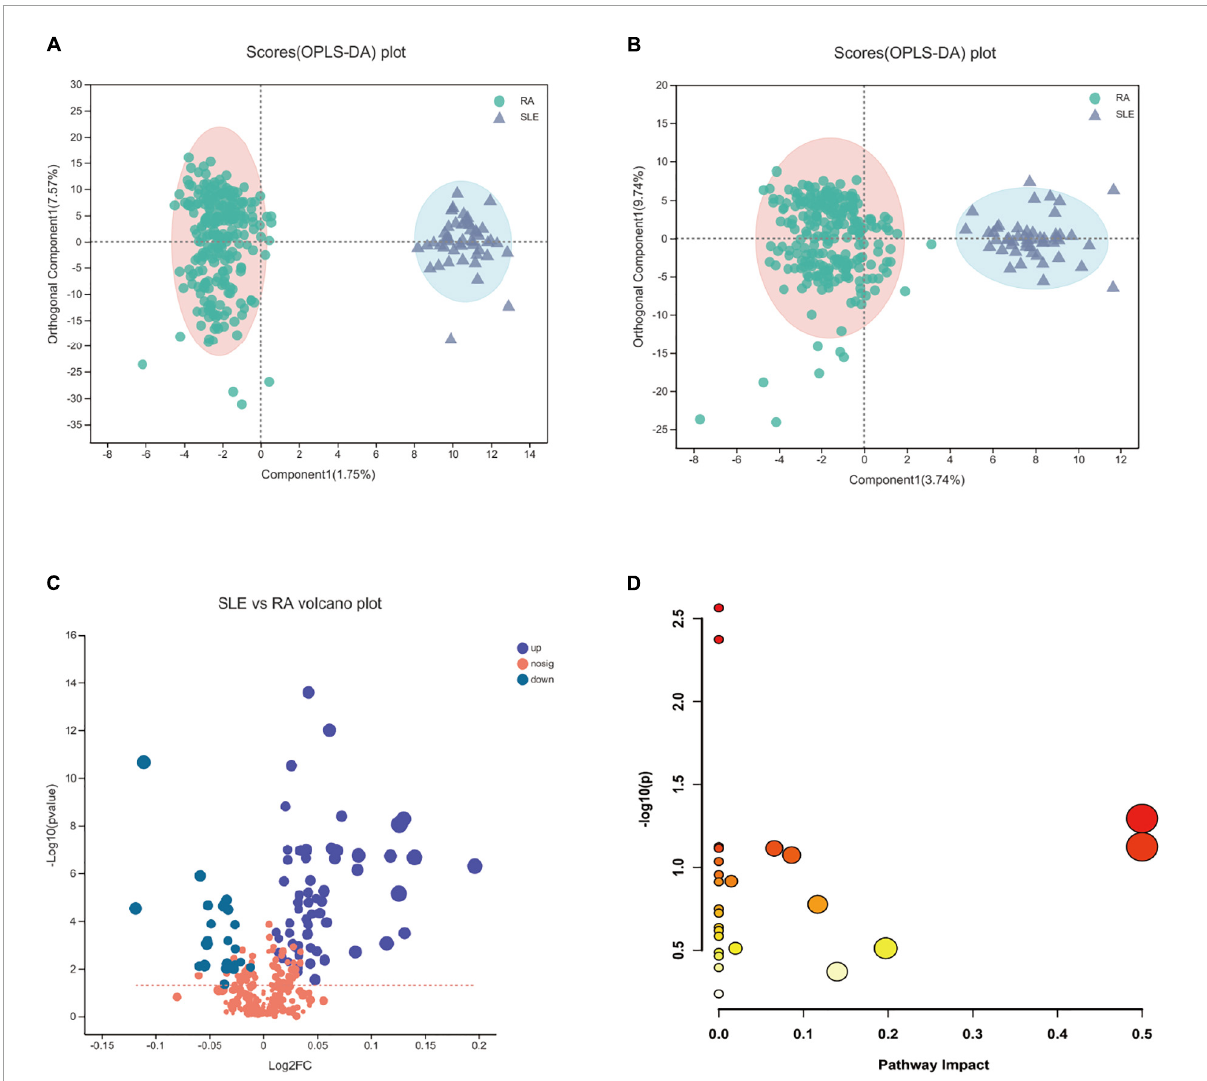
FIGURE3 The orthogonal partial least-squares discriminant analysis (OPLS-DA) and KEGG pathway analysis in RA patients compared to SLE patients. (A,B) The OPLS-DA plots between RA and SLE, cation, and anion, respectively. (C) The volcano plot of RA vs. SLE. (D) The KEGG pathway analysis results based on the significant metabolites between RA and SLE. RA, rheumatoid arthritis; SLE, systemic lupus